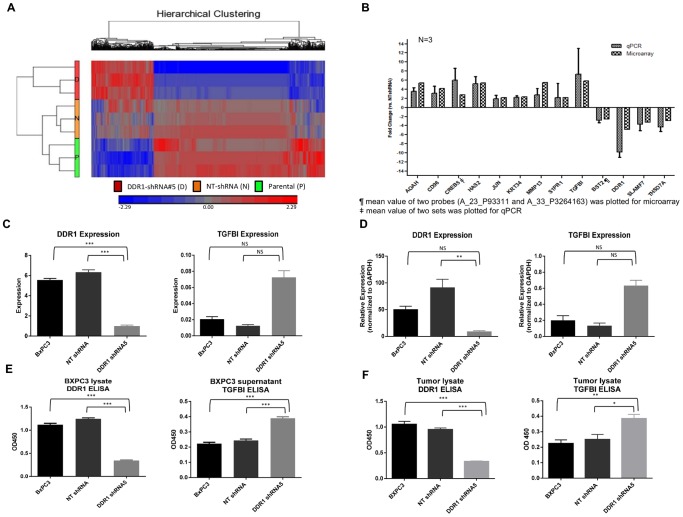
DDR1 knockdown induces upregulation of TGFBI.(a) Unsupervised hierarchical clustering of BXPC3 cells treated with DDR1 shRNA (D), NT shRNA (N) or untreated parental cells (P). (b) Expression validation of small subset of genes by microarray and qPCR. Mean value of two probes (A_23_P93311 and A_P3264163) was plotted for microarray. Mean value of two sets was plotted for qPCR. DDR1 and TGFBI expression in untreated, NT shRNA or DDR1 shRNA5 treated BXPC3 cells is measured by (c) microarray or (d) qPCR. (e) and (f) Relative DDR1 and TGFBI protein levels in untreated parental, NT shRNA or DDR1 shRNA5 treated BXPC3 cell lysates, supernatants or tumor lysates was measured by ELISA. Statistical significance is reported as *** (p<0.0001), ** (p≤0.005), * (p≤0.01), and NS (not significant).